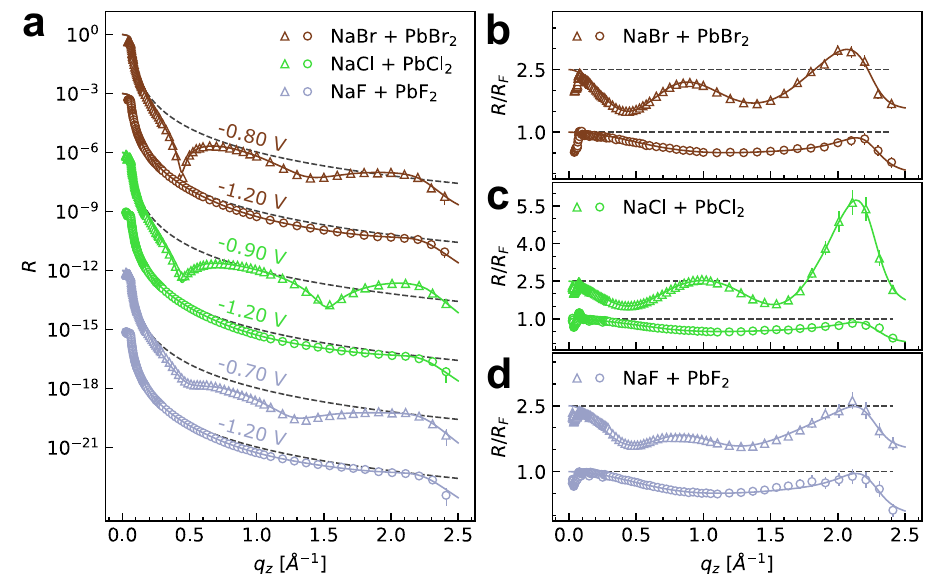
Fig. 2 | Structural data for the Hg interface structure in Pb halide solutions. a X-ray re fl ectivity R and b – d R normalized by the Fresnel re fl ectivity R F (indicated by dashed gray lines) of Hg electrodes in 0.01M NaBr+0.25mM PbBr 2 (brown symbols),0.01MNaCl+0.25mMPbCl 2 (greensymbols),and0.01MNaF+0.12mM PbF 2 (blue symbols). Triangles indicate curves measured at − 1.20V, open circles curves were measured in the potential range of de-amalgamation, at − 0.80V